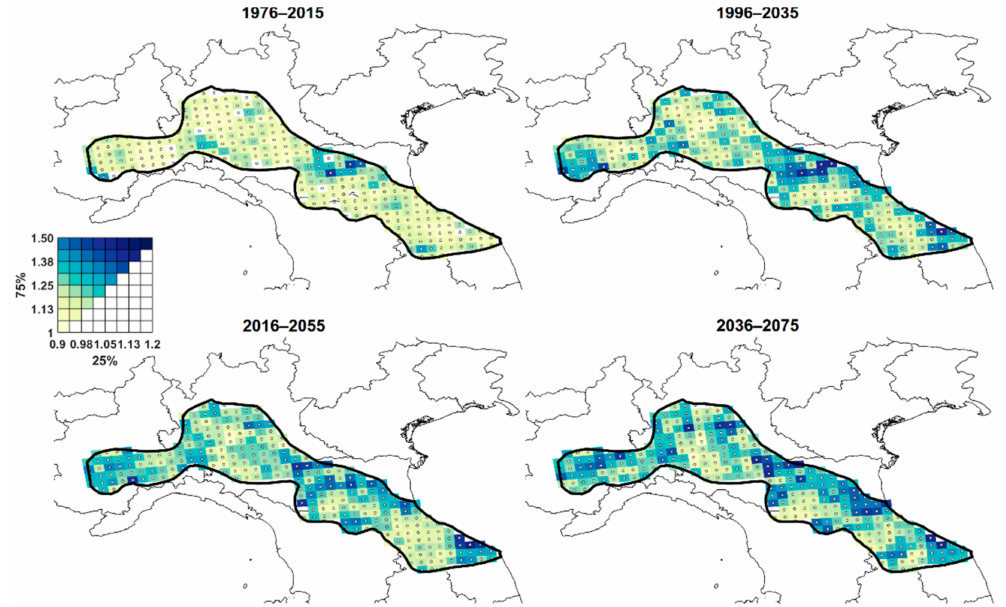
Figure 10. Factors of change for p r,k in the time windows 1976–2015, 1996–2035, 2016–2055, and 2036–2075 in comparison with the reference time interval 1956–1995—prediction interval (25–75%) map (Scenario RCP4.5).